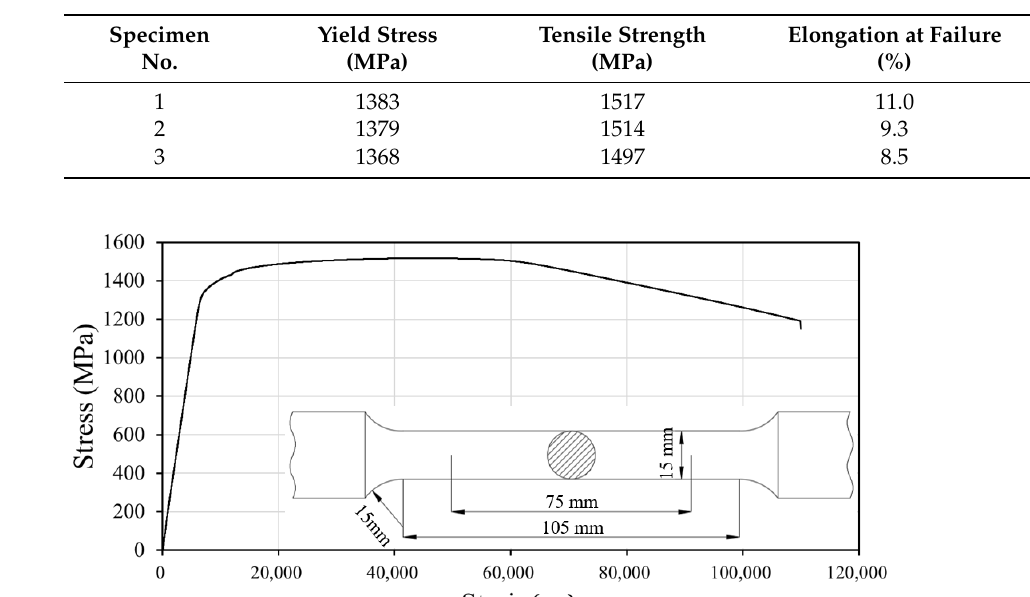
Figure 3. Stress versus strain curve (for coupon specimen 1).